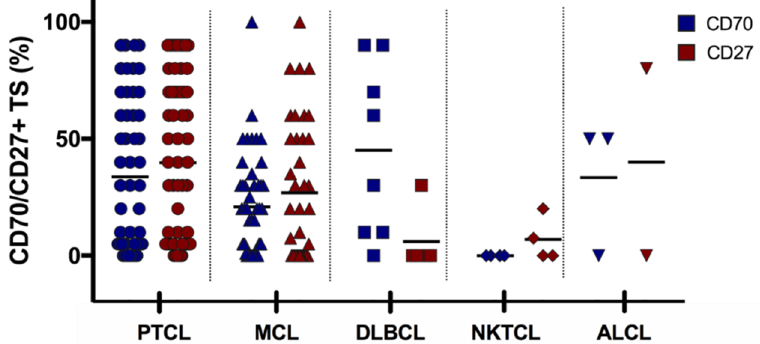
Figure 6. Overview of CD70 and CD27 expression in 117 lymphoma samples. Each symbol represents a different patient’s sample and bars represent the mean. ALCL, anaplastic large cell lymphoma; DLBCL, diffuse large B cell lymphoma; MCL, mantle cell lymphoma; NKTCL, NK/T cell lymphoma PTCL, peripheral T-cell lymphoma. TS, tumour sample